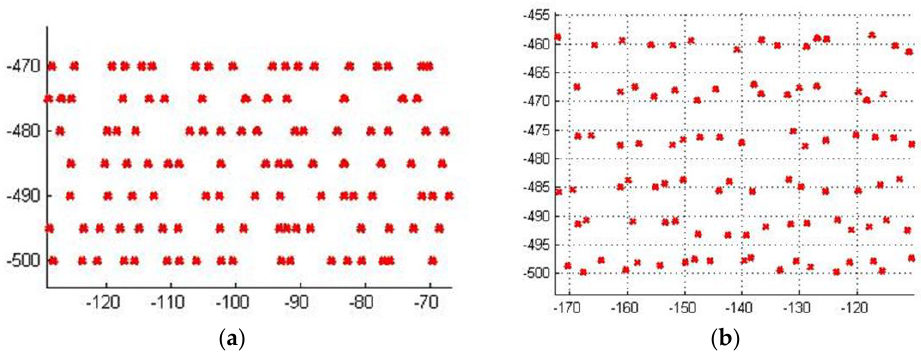
Figure 13. Points distribution on the ( u , v ) domain when sampling along u -section line: ( a ) the case when u -fluctuation is equal to zero; ( b ) the case when u -fluctuation ranges from −1.5 to 1.5 randomly. In this picture, v direction is the horizontal direction, and u direction is the vertical direction.